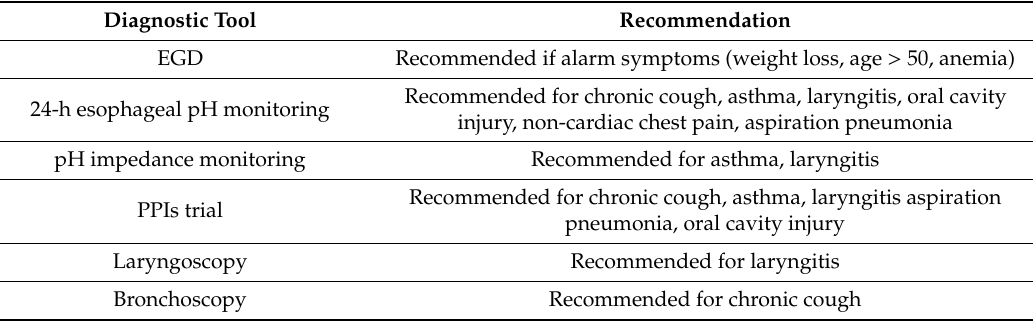
Table 3. Diagnostic tools for extra-esophageal (EE) GERD. EGD: esophagogastroduodenoscopy, PPIs: proton pump